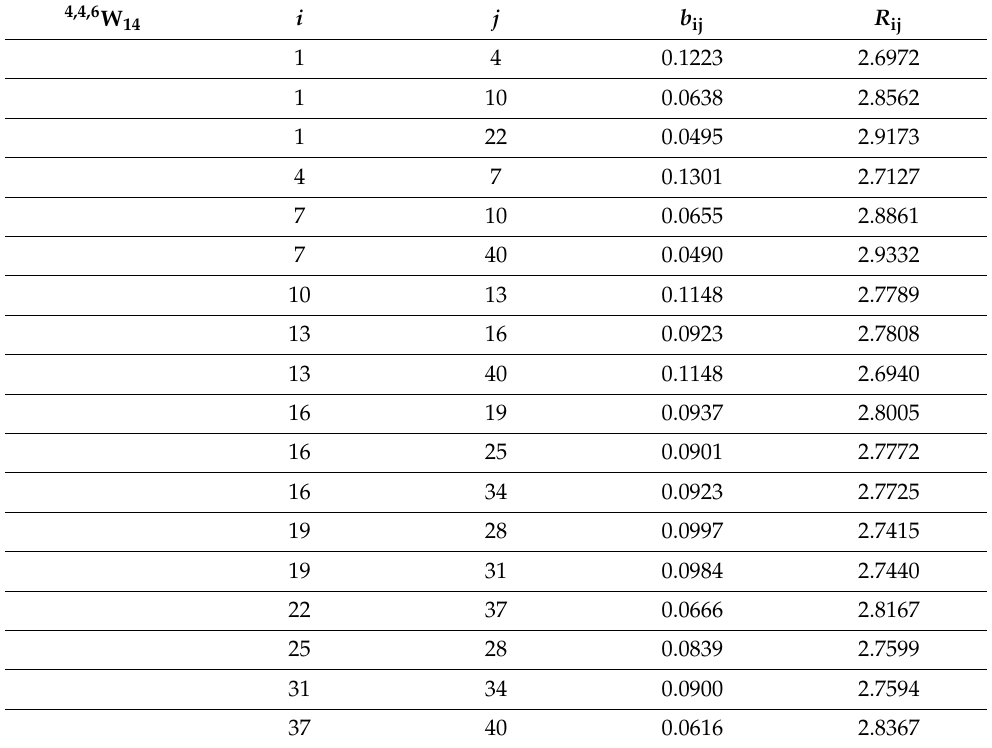
Table 2. NRT bond orders b ij and bond lengths R ij (Å) for all O( i ) ··· O( j ) H-bonds of the 4,4,6 W 14 cluster (with atom numberings as shown in Figure 3). (See SI for similar tables for all clusters of the present work).